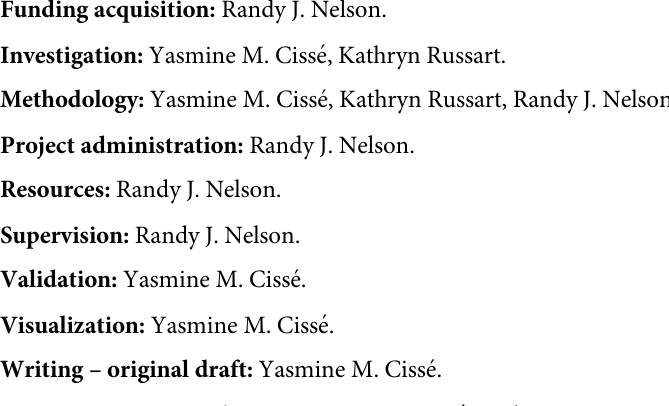
S1 Fig. Exposure to dLAN prior to conception does not alter maternal care. Percentage of time observed engaged in nursing behavior averaged from three daily observation across the first postnatal week. N = 6-9/group; error bars represent